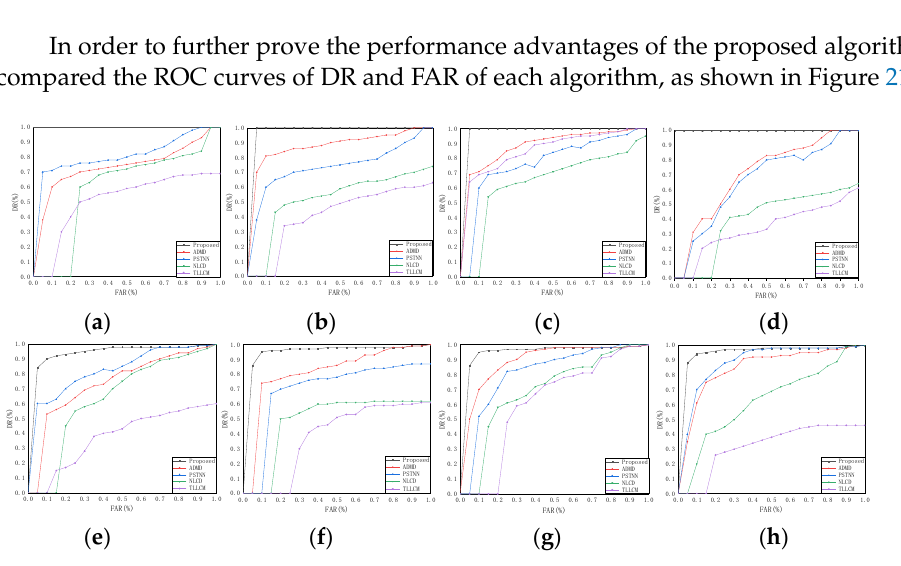
Figure 21. ( a – h ) is ROC curves of detection results of eight real sequences.